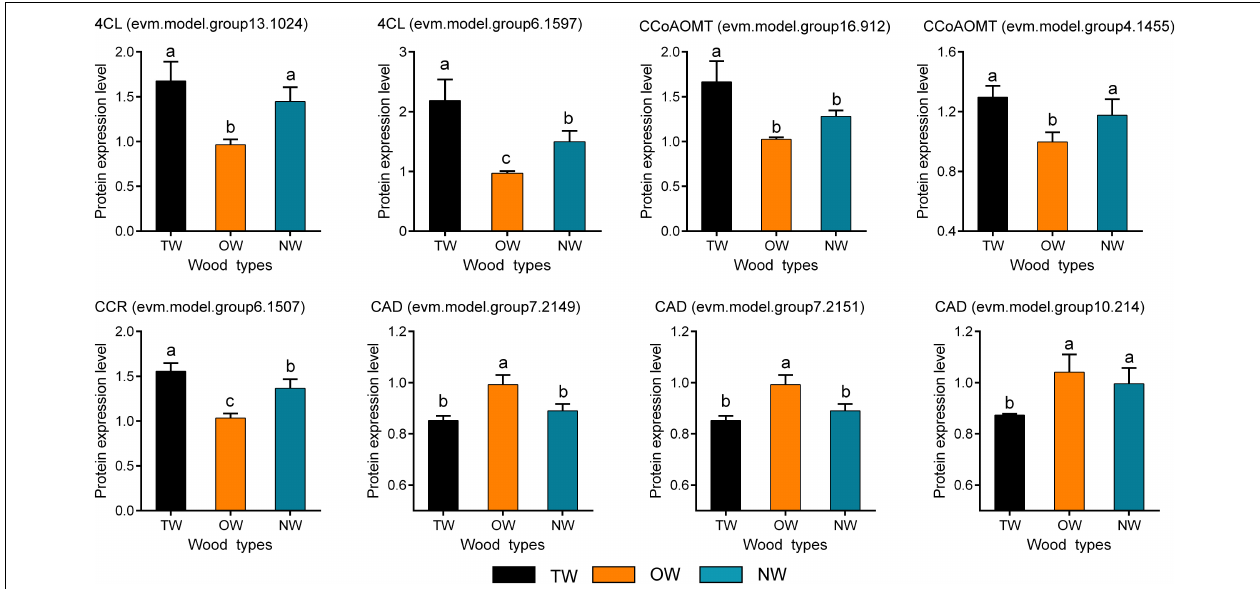
FIGURE 7 | The expression of candidate proteins involved in lignin monomer biosynthesis in tension wood (TW), opposite wood (OW), and normal wood (NW). Duncan’s method was used for multiple comparisons. Different lowercase letters indicate a 5% significant difference. One of the biological repetitions of OW serves as a reference for calculating protein relative